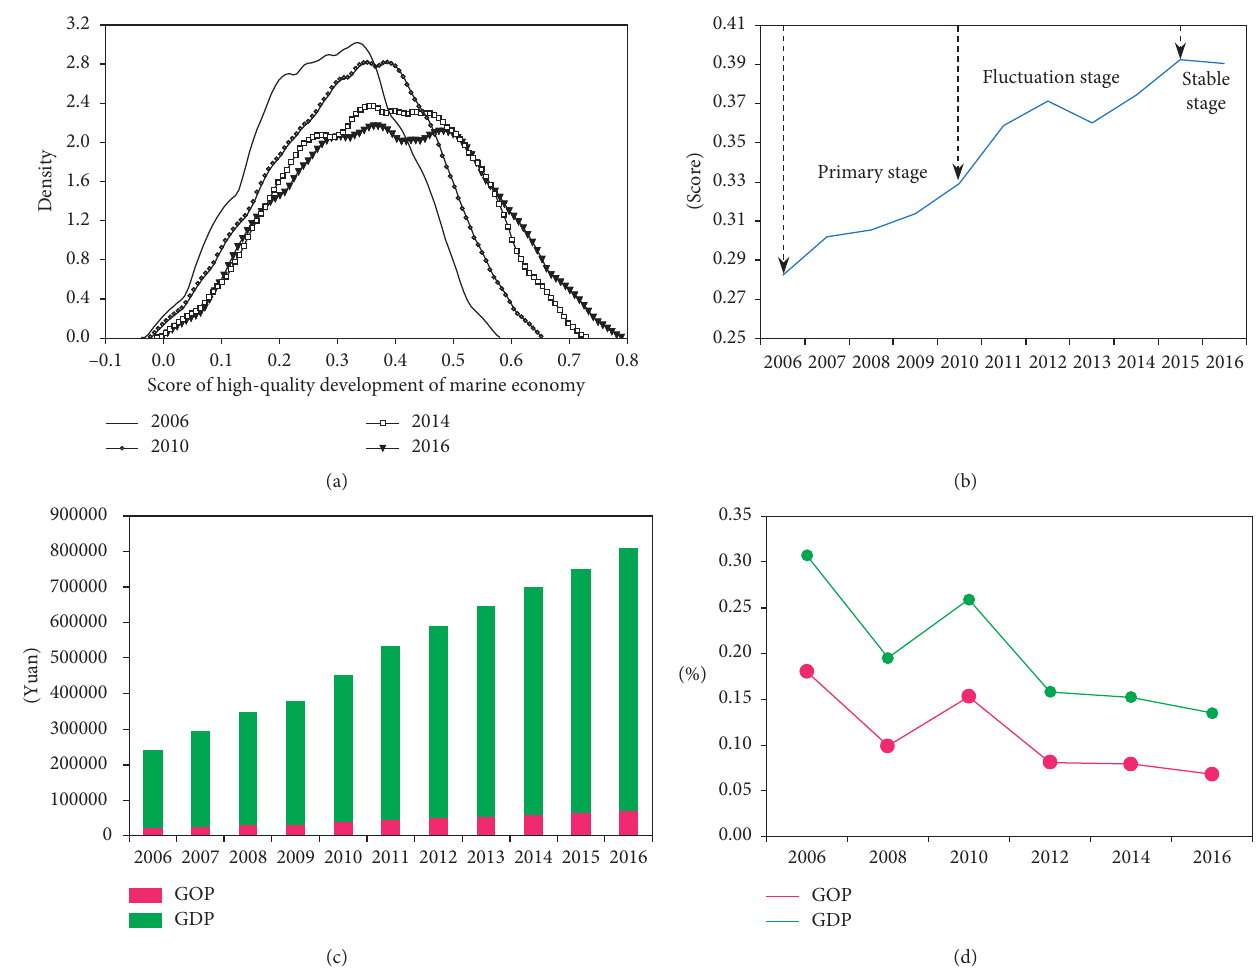
Figure 3: Time evolution and stage division of the high-quality development of marine economy. (a) Nuclear density distribution. (b) Time stage. (c) GOP and GDP output. (d) Growth rate of GOP and